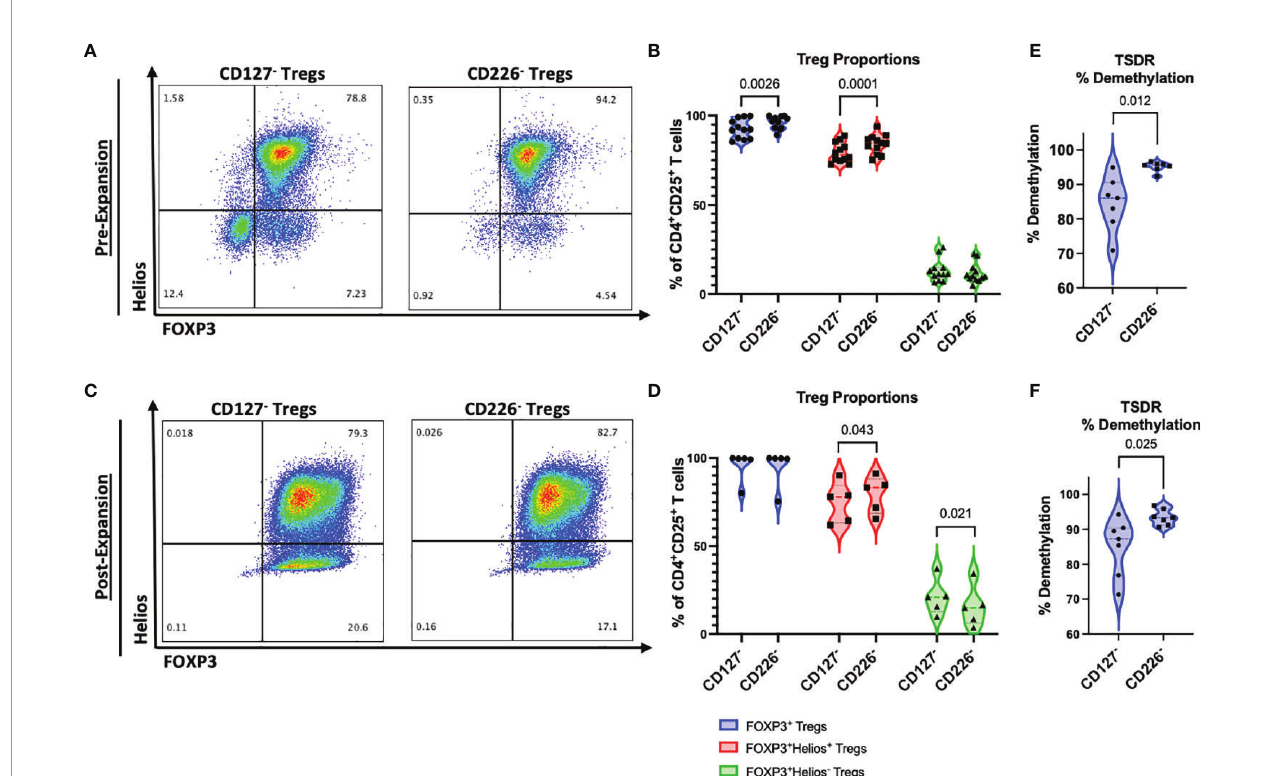
FIGURE 3 | CD226 - Tregs maintain higher purity than conventionally sorted CD127 lo/- Tregs. Tregs from each FACS method were examined for FOXP3 and Helios expression (A, B) at day 0 following isolation ( n = 12 biological with n = 2 technical replicates) and (C, D) at day 14 following ex vivo expansion ( n = 5 biological with n = 2 technical replicates). (A, C) Representative fl ow plots pre-gated on live CD4 + CD25 + cells show percentages of Treg subsets for CD127 lo/- sorted Tregs and CD226 - sorted Tregs. (B, D) Percentages of CD4 + CD25 + FOXP3 + Tregs (blue), CD4 + CD25 + FOXP3 + Helios + Tregs (red), and CD4 + CD25 + FOXP3 + Helios - Tregs (green) per FACS isolation method. P-values are reported on the fi gure for two-way ANOVA with Bonferroni post-hoc correction for multiple comparisons of Treg isolation conditions from matched subjects. (E, F) Percent demethylation at the TSDR of CD127 lo/- and CD226 - sorted Treg cultures, (E) pre-expansion and (F) post- expansion. Signi fi cant P-values are reported on the fi gure for paired T-tests, n = 7 biological with n = 2 technical